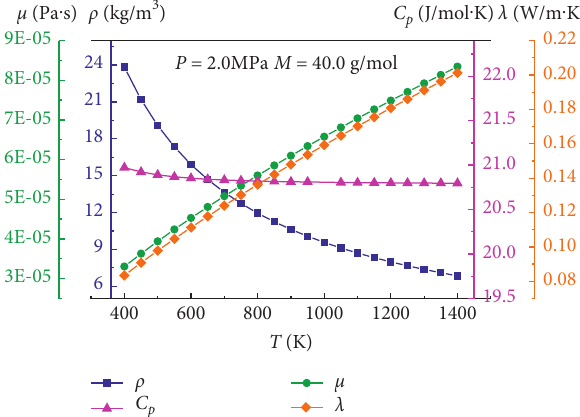
Figure 3: Variations of Pr t for fluids with different Prandtl numbers.